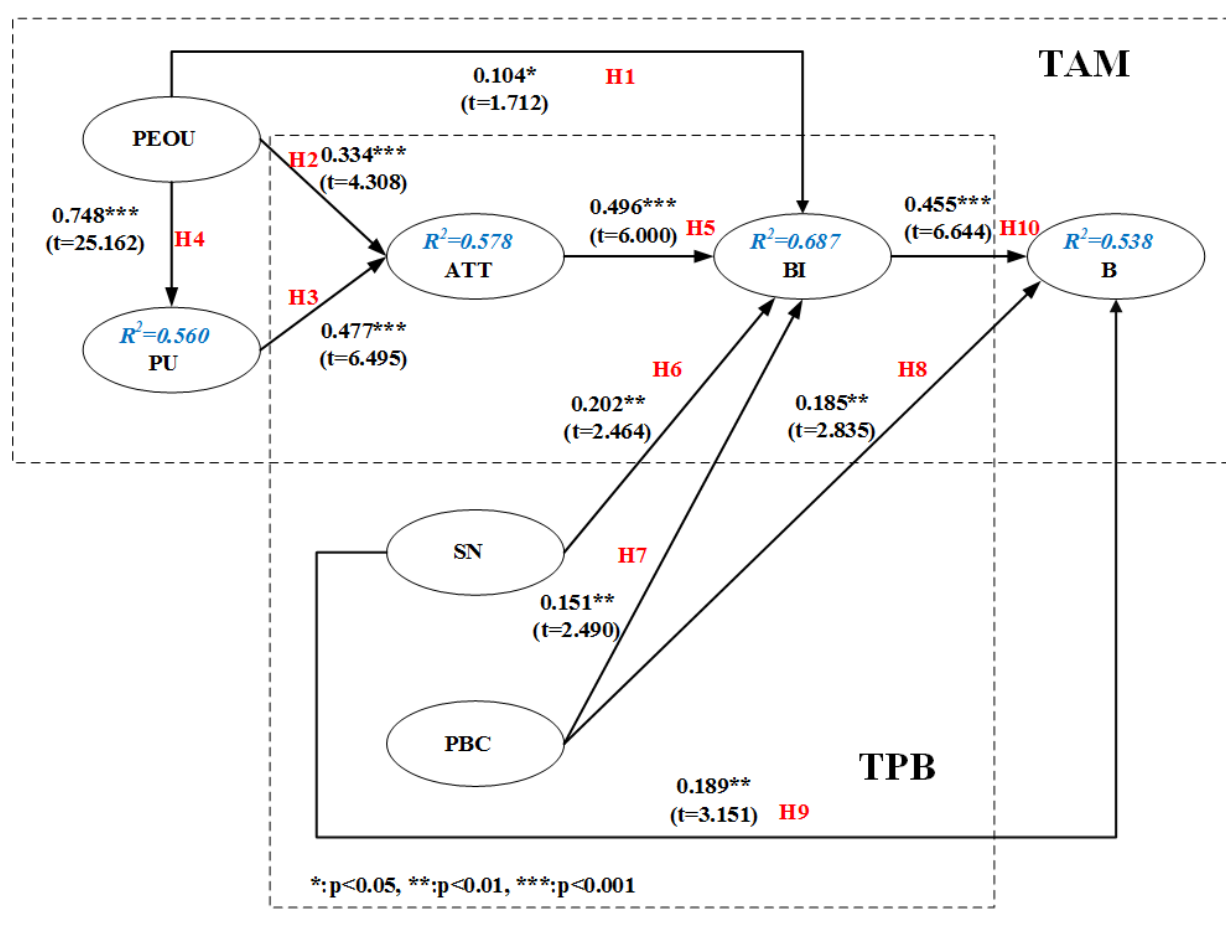
Figure 2 . Structural model PLS